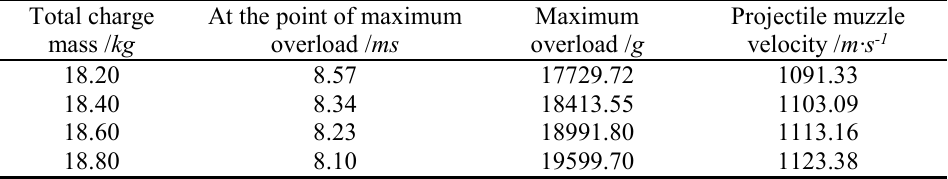
Table 2. Influence of charge mass on internal ballistic overload